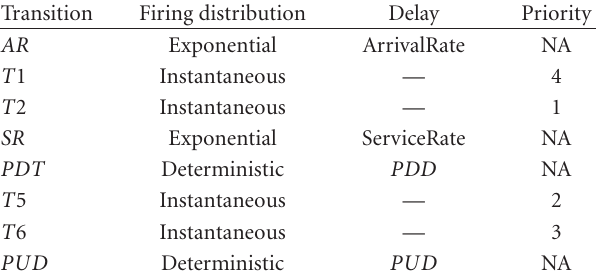
Table 1: Petri net transition parameters for CPU jobs.